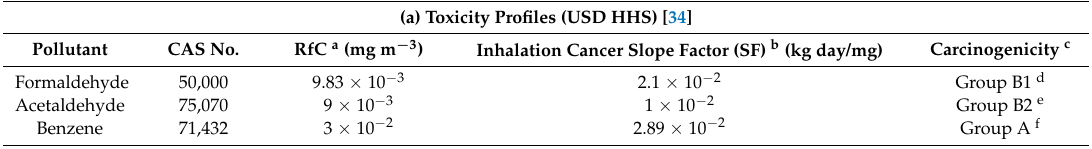
Table 1. Toxicity profiles for formaldehyde, acetaldehyde, and